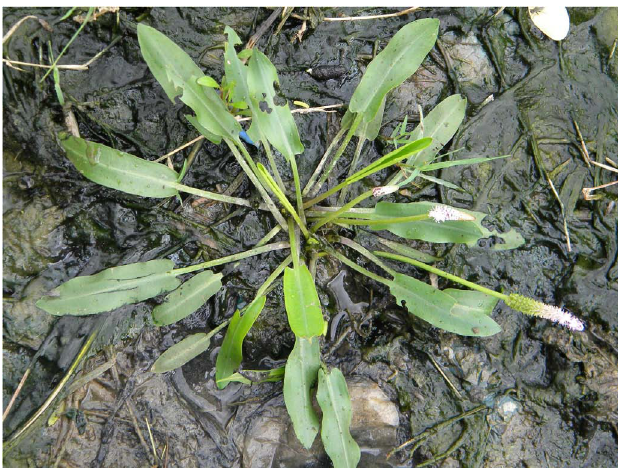
Figure 6. Lemna gibba ecosystem, associated to the tiny